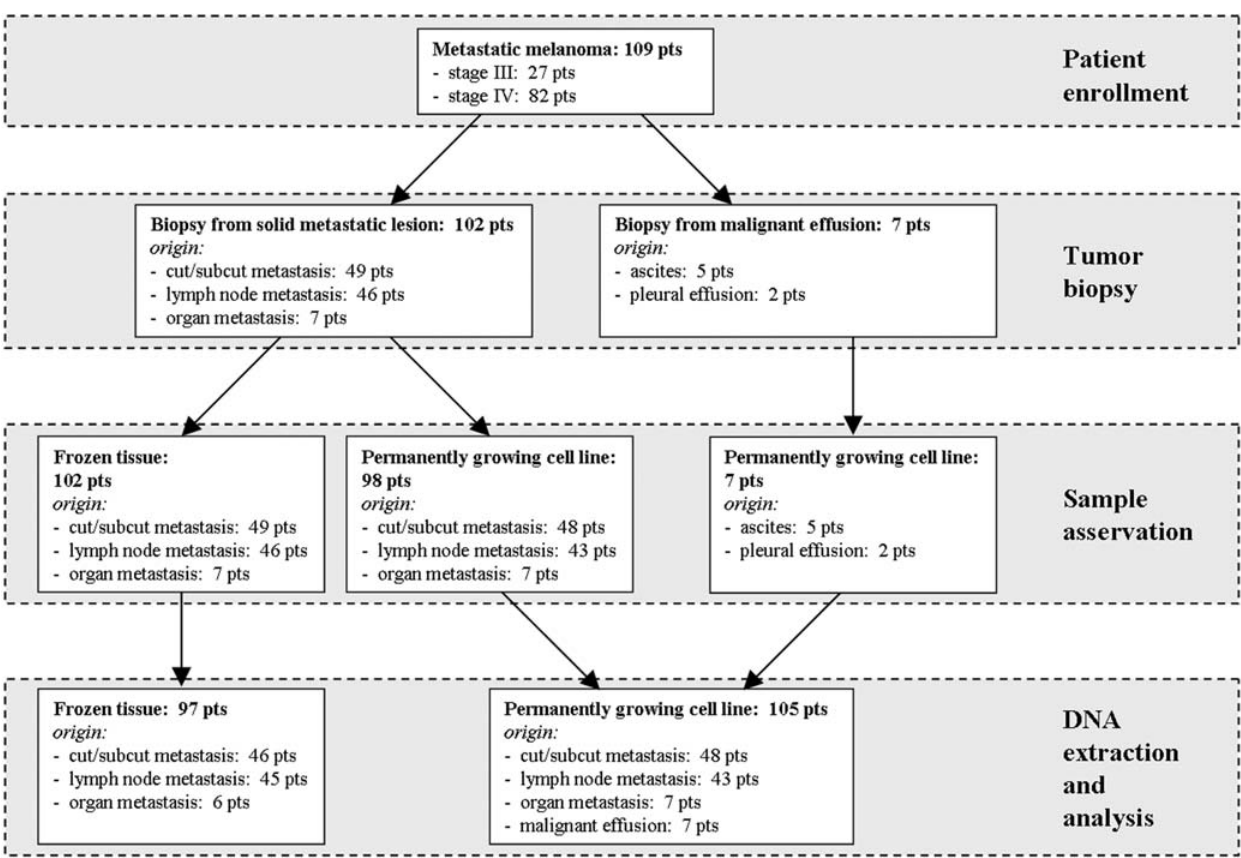
Figure 1. Schematic presentation of the study flow.